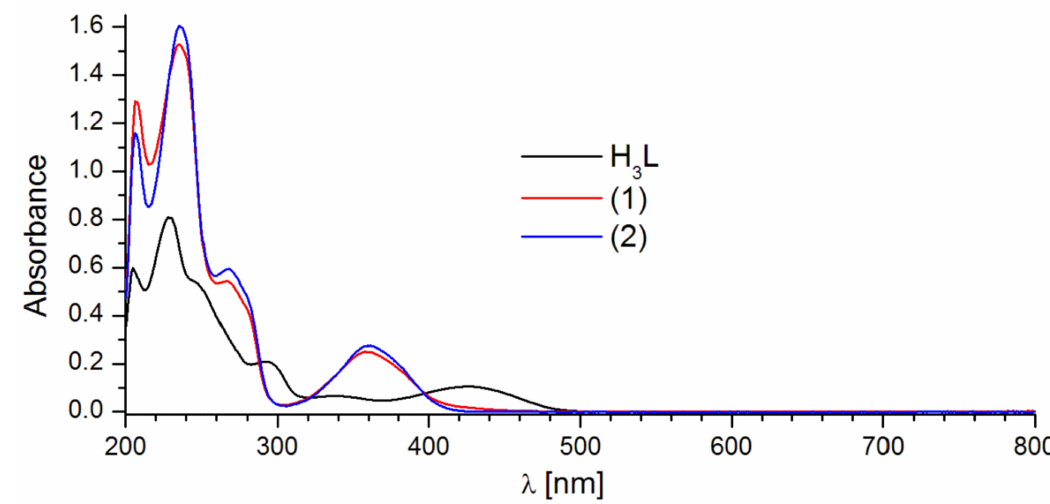
Figure 4. The absorbance spectra of H 3 L ligand and complexes 1 (Zn II –Nd III –Zn II ) and 2 (Zn II –Sm III –Zn II ) in methanol solution (~2 · 10 − 5